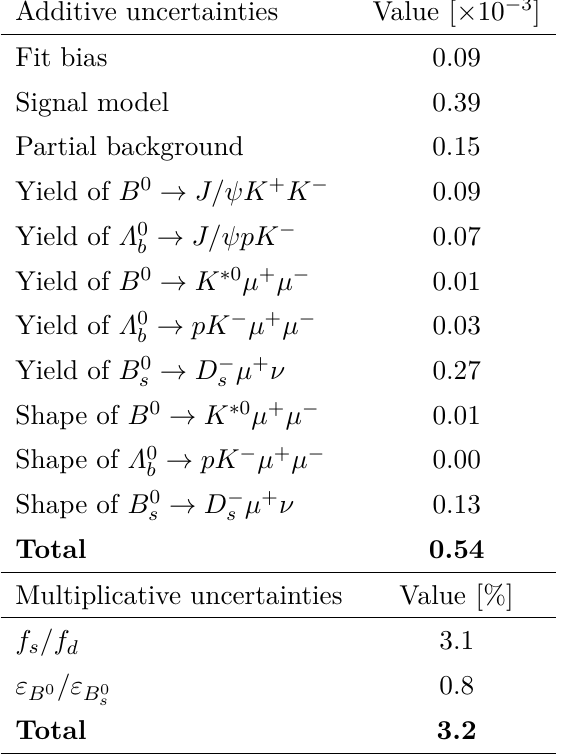
Changing this yield by ± 1 standard deviations and repeating the B 0 the maximum change of R is 0 . 27 × 10 − 3 , which is assigned as a systematic uncertainty. the B 0 → φµ + µ − sample are also studied and found to be small. Changing the fixed yield ( s ) of the B 0 → J/ψK + K − ( Λ 0 → J/ψpK − ) component in the B 0 b